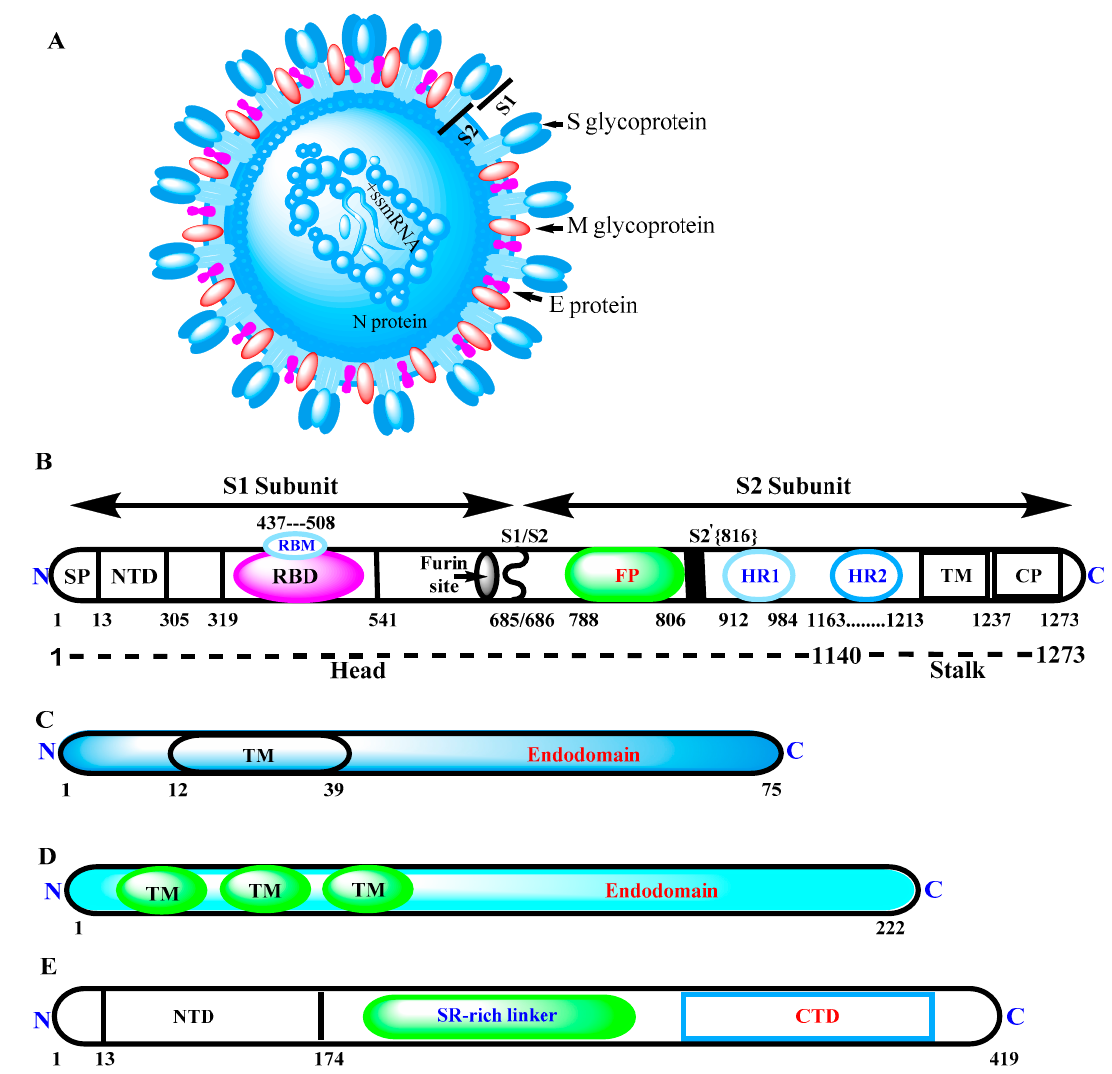
Figure 3. SARS-CoV-2 virion with its multiple structural proteins, namely, S, M, E, and N. ( A ) Structure of enveloped SARS-CoV-2 virion, depicting location of different structural proteins and +ss mRNA genome. ( B ) Structure of spike (S) protein, containing multiple domains and motifs in specific order, such as: N-terminus; SP—signal peptide; NTD—N- terminal domain; RBM—receptor-binding motif; RBD—receptor-binding domain; FP—fusion peptide; HR1—heptad repeat 1; HR2—heptad repeat 2; TM—transmembrane domain; CP—cytoplasm domain C-terminus. ( C ) Structure of envelope ( E ) protein, consisting of: N terminus; TM—transmembrane domain C-terminus. ( D ) Structure of membrane (M) protein, possessing N-terminus transmembrane domains TM and endodomain C-terminus. ( E ) Structure of N protein, consisting of: N-terminus; NTD-N—terminal domain; serine (SR)-rich linker region; NTD—N terminal domain; C-terminus. The position of each domain on S, M, E, and N may not be exactly scaled to amino acid residues owing to variability in published literatures. Even number of domains, as well as domain-specific function may be